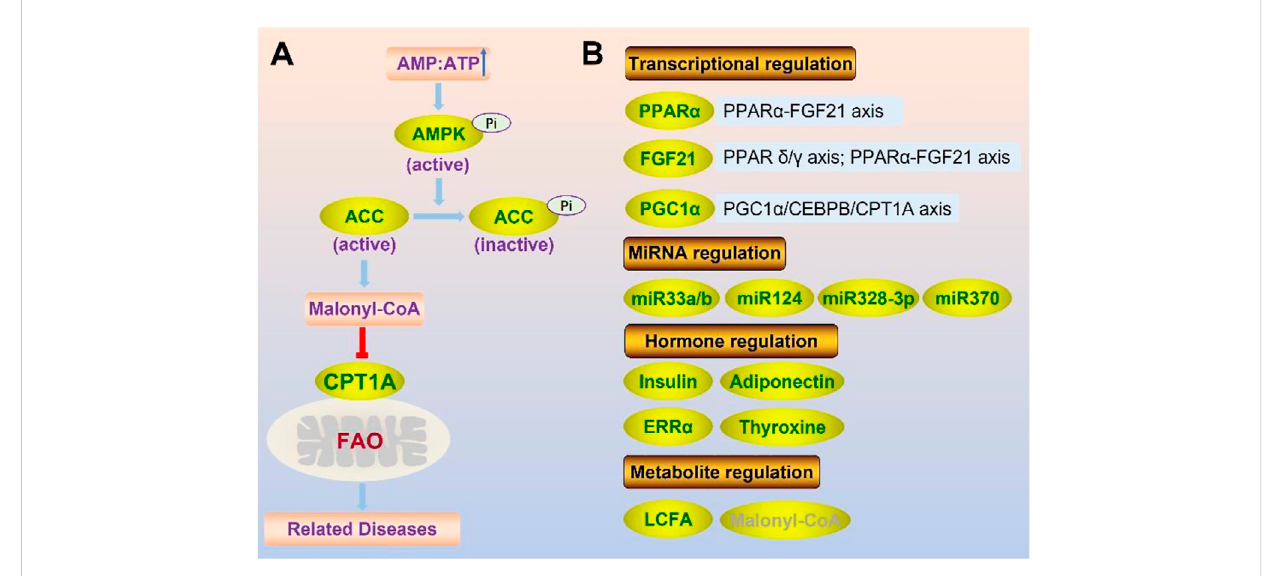
FIGURE 5 Regulation of CPT1A at protein level (enzyme activity) (A) and gene expression level (B)